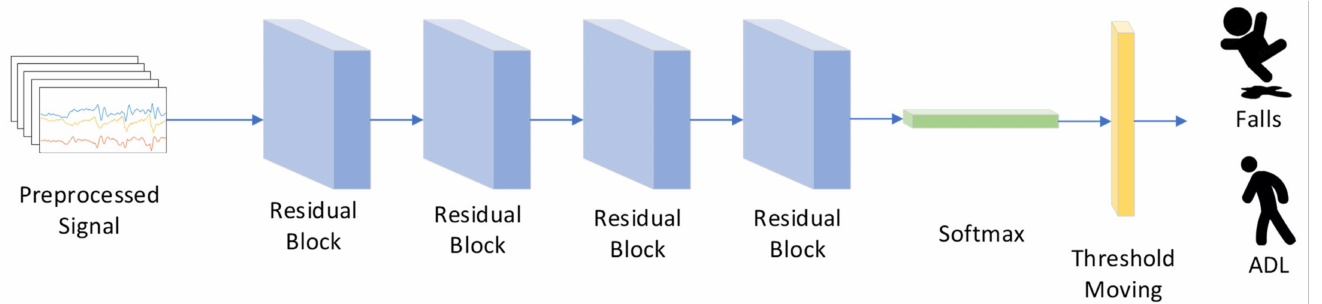
Figure 4. The structure of CDL-Fall